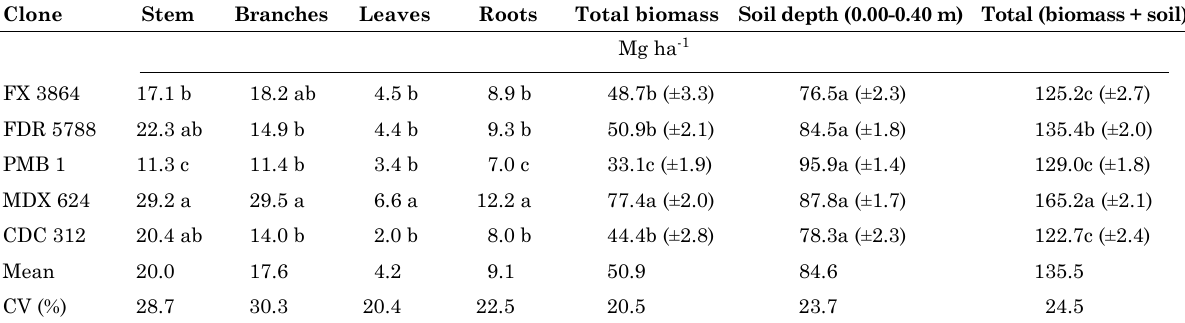
Table 4. Carbon stored in the different parts of the tree, total C biomass stored in the rubber tree clones, total C stock in soil (0.00-0.40 m), and total C stored (biomass + soil) in the plantings of rubber tree